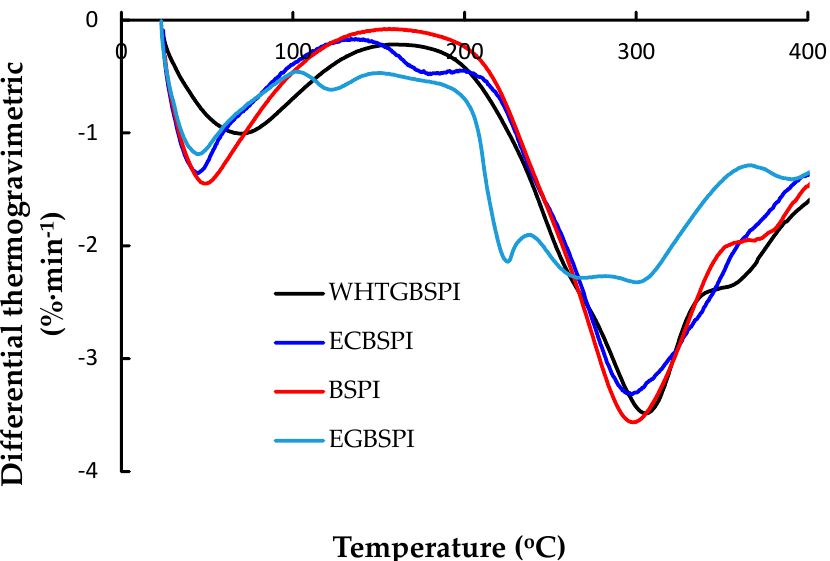
Figure 5. Differential thermogravimetric curves of BSPI and its modified products.